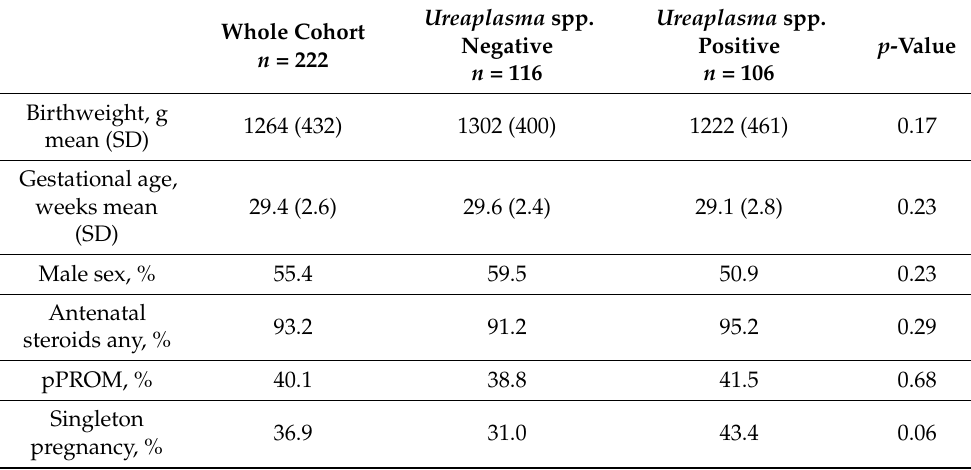
Table 1. Clinical characteristics of study patients according to vaginal Ureaplasma spp.